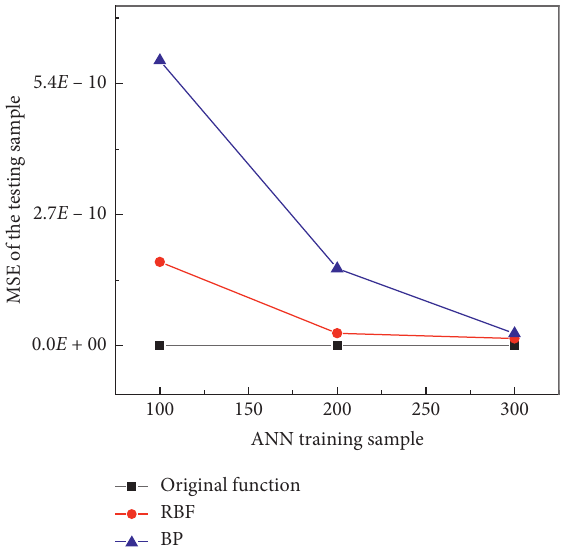
Figure 8: Comparison the change of MSE between RBF and BP as the ANN sample data size change.